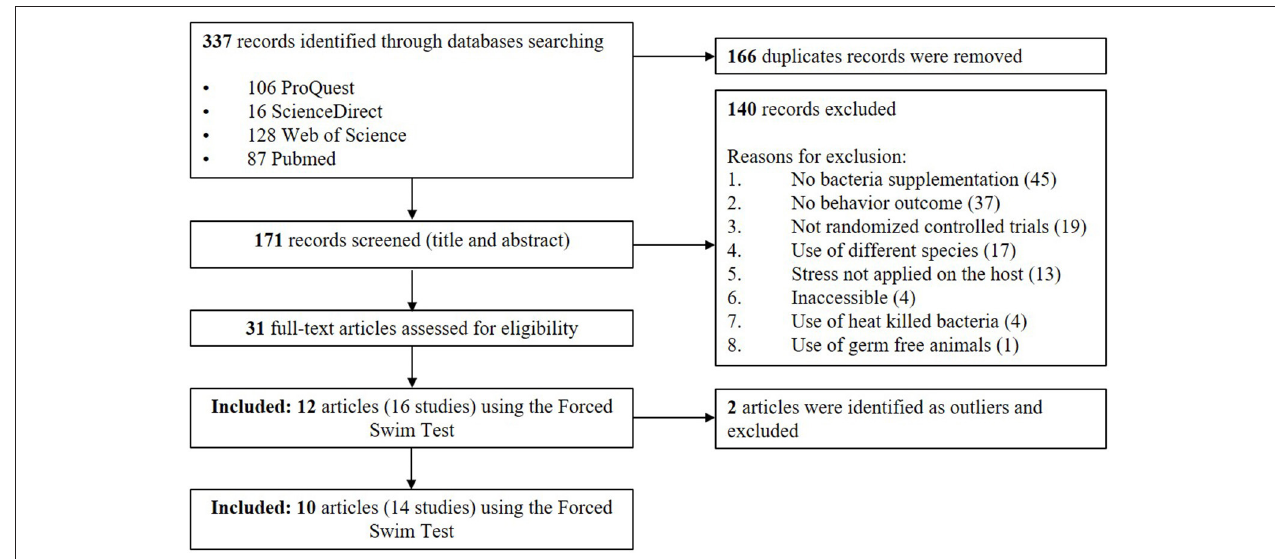
FIGURE 1 | PRISMA flow diagram of studies included in meta-analysis— Lactobacillus -based probiotics reduce the adverse effects of stress in